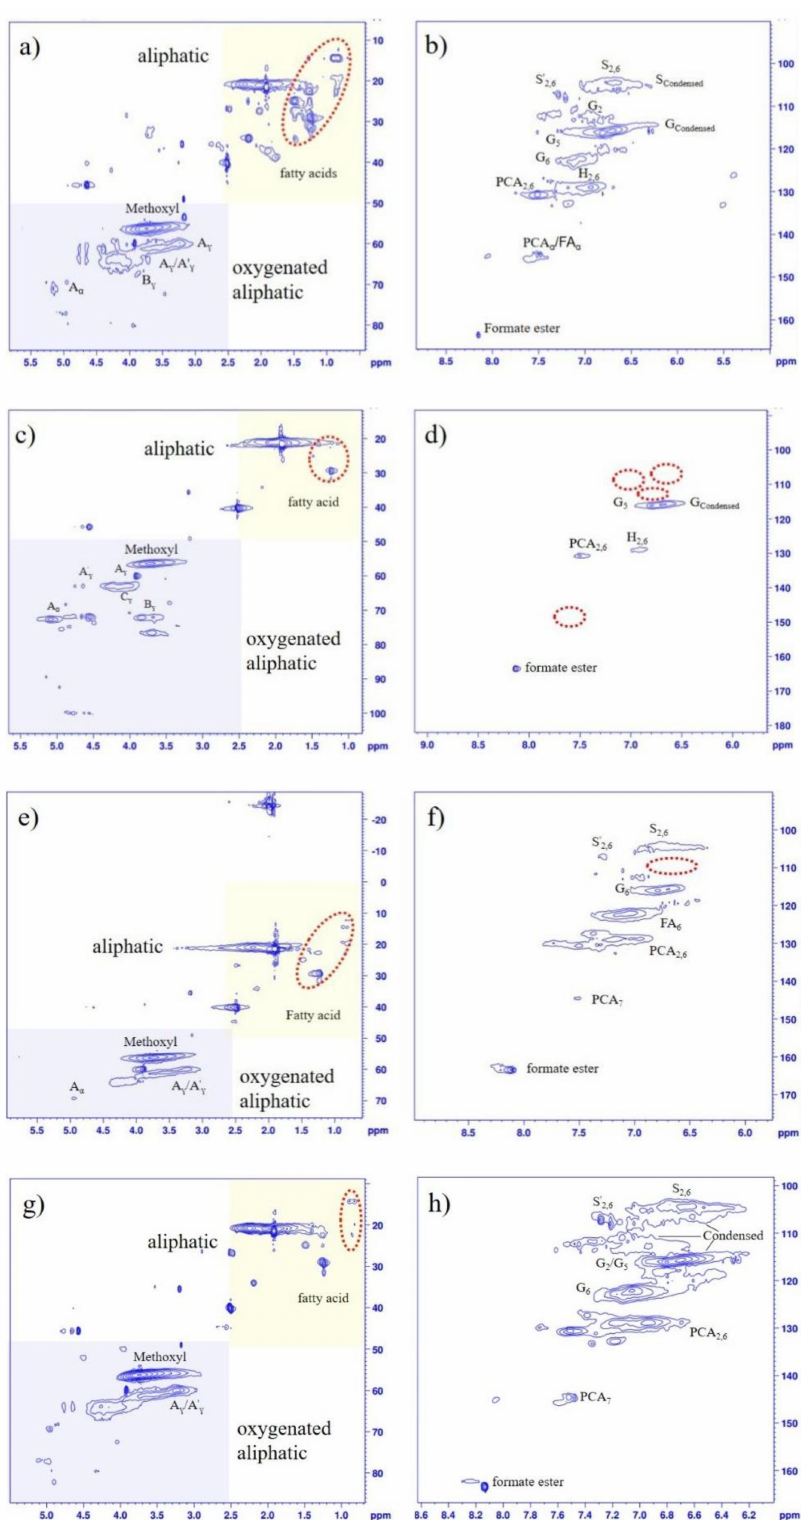
Figure 3. HSQC-NMR spectra of the isolated lignin fractions obtained from two-step formosolv fractionation (left column: side chain region; right column: aromatic region). ( a , b ): FL-88%; ( c , d ): FIL-70%; ( e , f ): FSL-70%; ( g , h ):